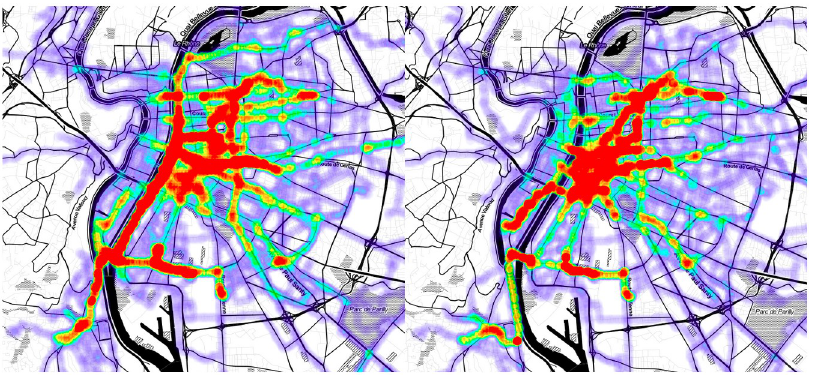
Fig 3. Heat-maps of the experienced tracks (on the left) and the computed tracks (on the right).